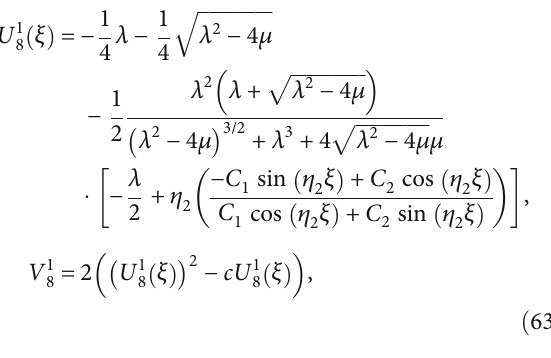
p ffiffiffiffiffiffiffiffiffiffiffiffiffiffiffi ffiffiffiffiffiffiffiffiffiffiffiffiffiffiffi λ 2 − 4 μ ffiffiffiffiffiffiffiffiffiffiffiffiffiffiffi p(cid:4)